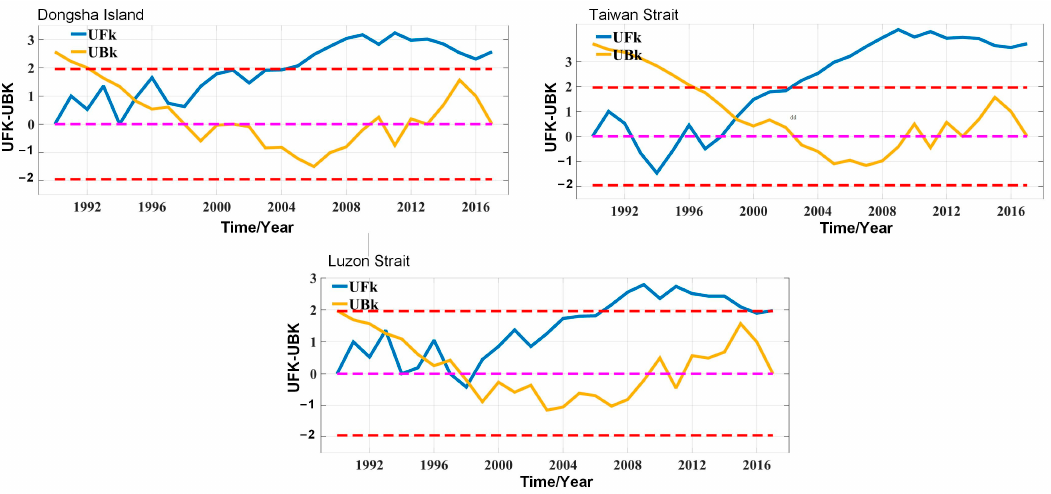
Figure 10. Dominant sea area year-by-year MK test.